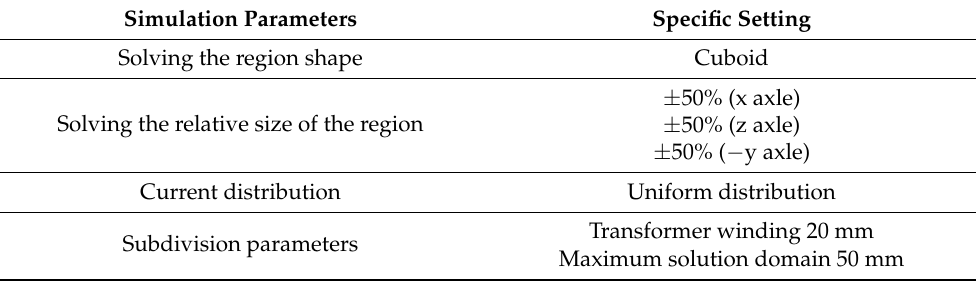
Table 1. FEA specification of key parameters.